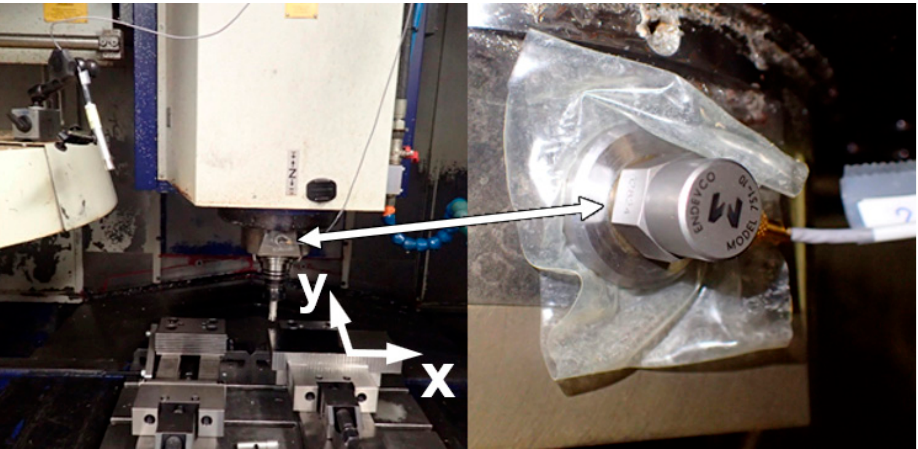
Figure 1. Experimental setup and position of the sensor on the spindle. The uniaxial accelerometer is oriented in the Y direction (detail on the right side).